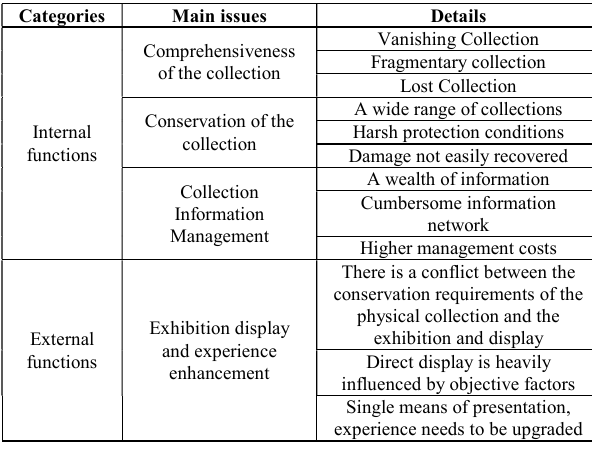
Table 3. Summary of main